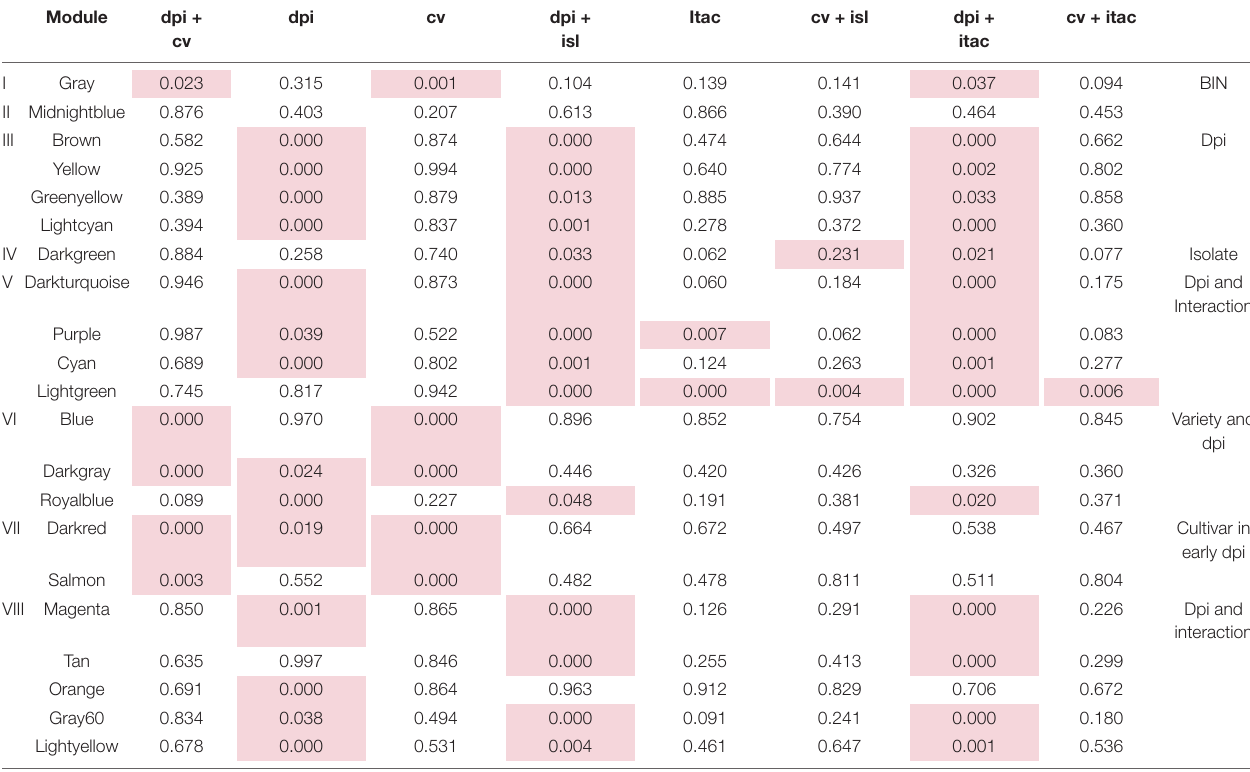
TABLE 3 | p -Values from GLM analysis depicting differences in between the identified co-expression gene modules.